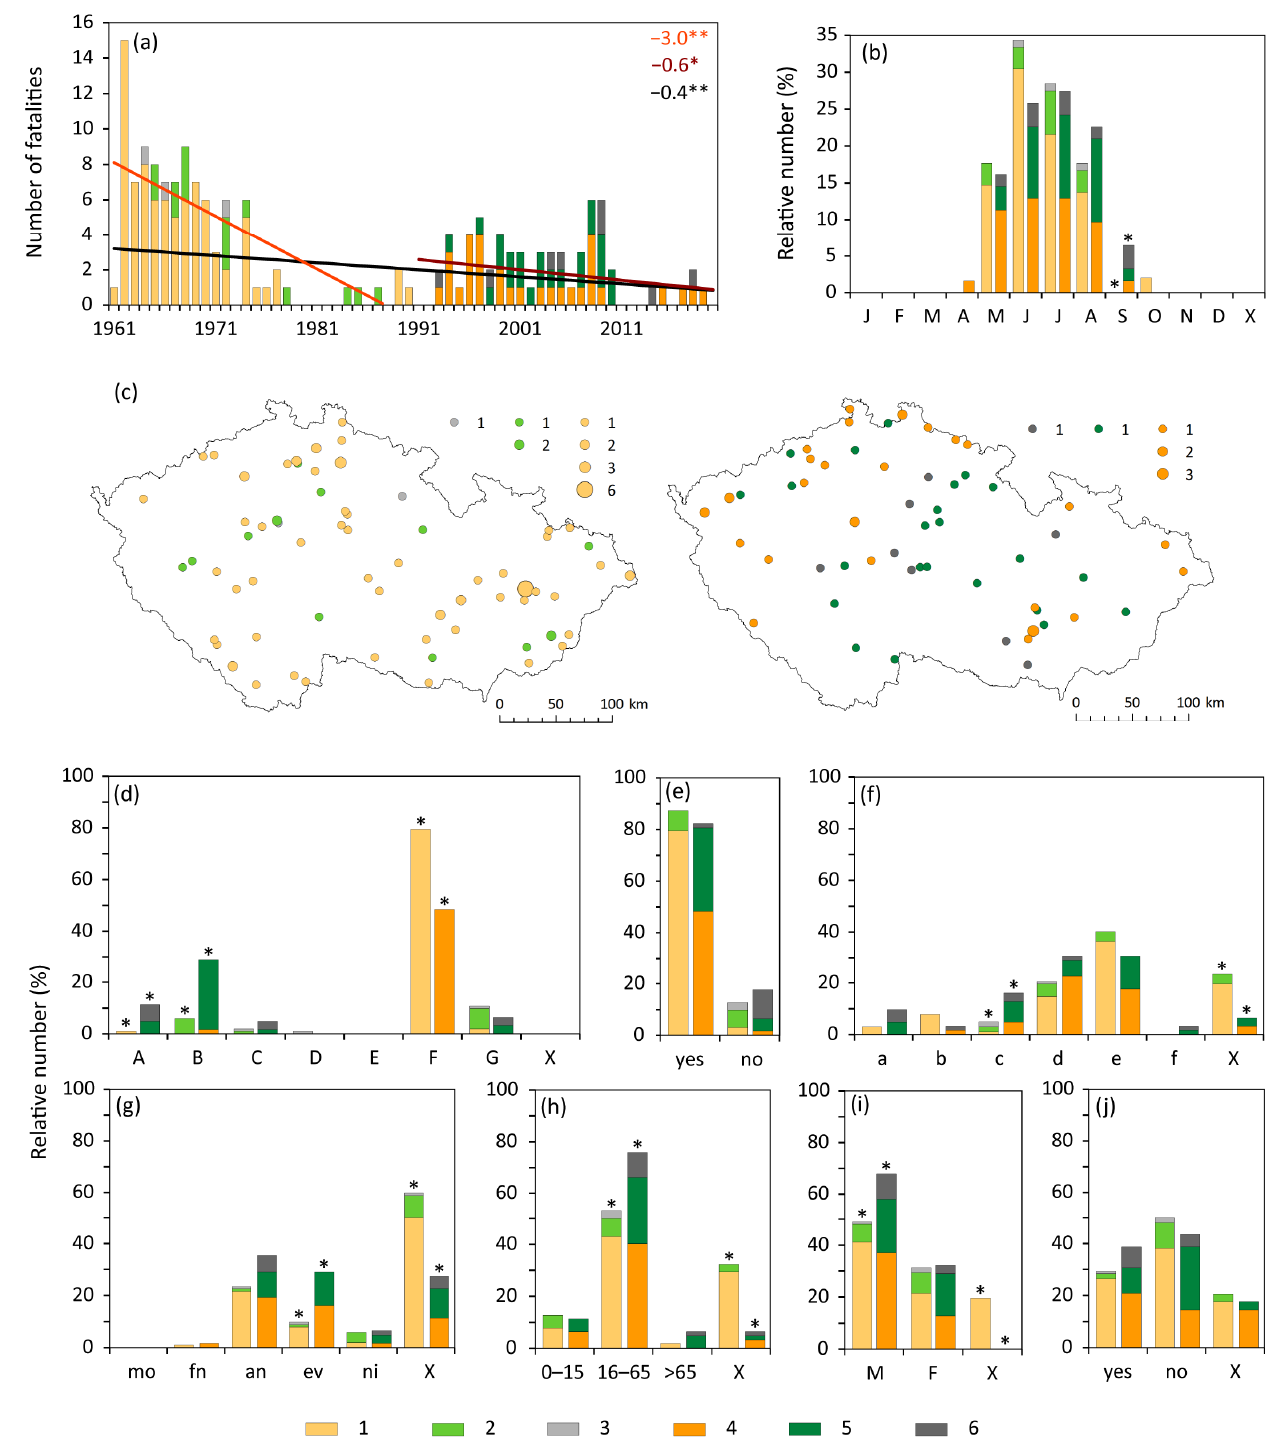
Figure 4. Characteristics of fatalities associated with convective storms in the Czech Republic during the 1961–1990 (1—lightning strike, 2—strong wind, 3—during a thunderstorm) and 1991–2020 (4—lightning strike, 5—strong wind, 6—during a thunderstorm) periods. ( a ) Fluctuations with linear trends (top right in fatalities/10 years for both 30 years and 1961–2020, trends with ** are significant for p < 0.05 and with * for p < 0.10); ( b ) annual variation; ( c ) spatial distribution (20 fatalities in 1961–1990 lack exact location); ( d ) cause of death; ( e ) type of fatality (direct); ( f ) place of death; ( g ) time of day; ( h ) age; ( i ) gender; ( j ) behaviour (hazardous). For an explanation of symbols and abbreviations see Figure 2.